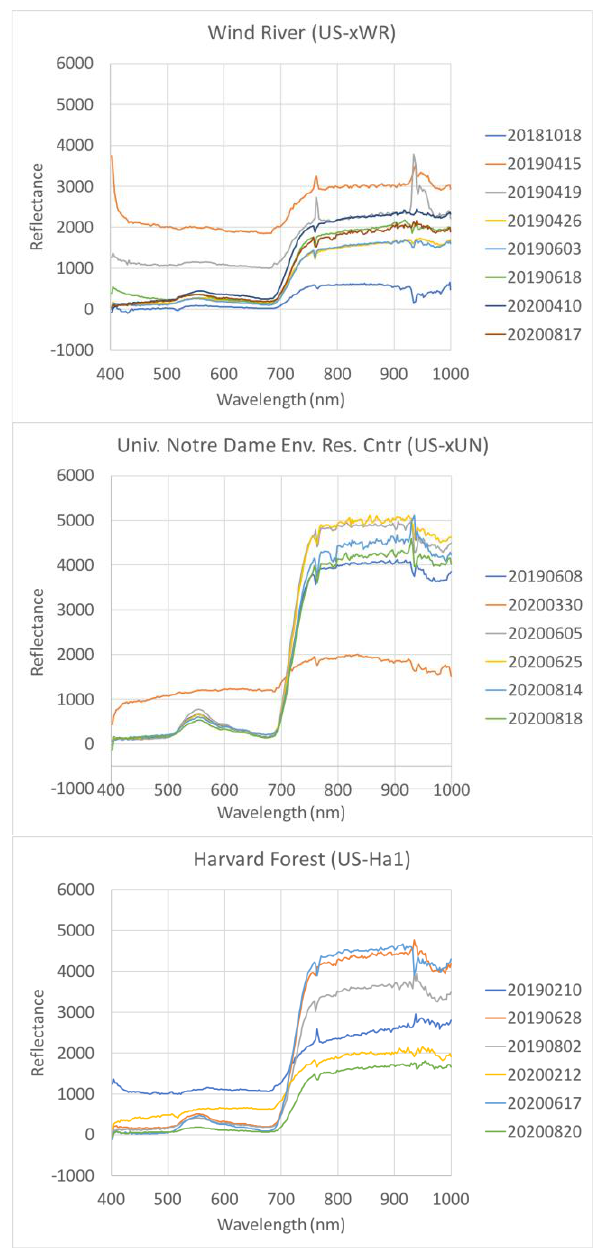
Figure 2 . Average DESIS surface reflectance spectra for areas around flux towers. The y-axis units are reflectance * 10 4 .